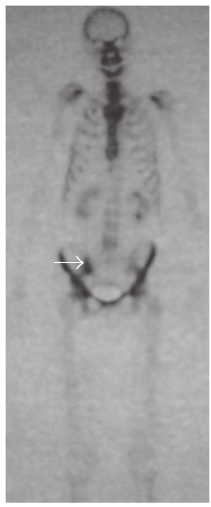
Figure 1: Technetium-99m MDP bone scintigraphy of the anterior pelvis shows increased uptake in the right sacroiliac joint (arrow).